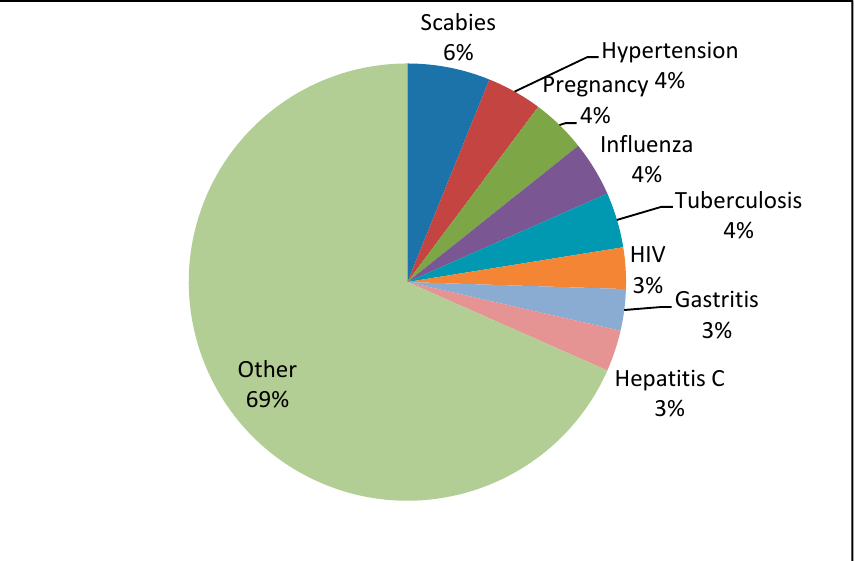
Figure 1. Results from the reflective diaries: showing the proportion of different diagnoses which were made in the outpatient clinic for general medicine.